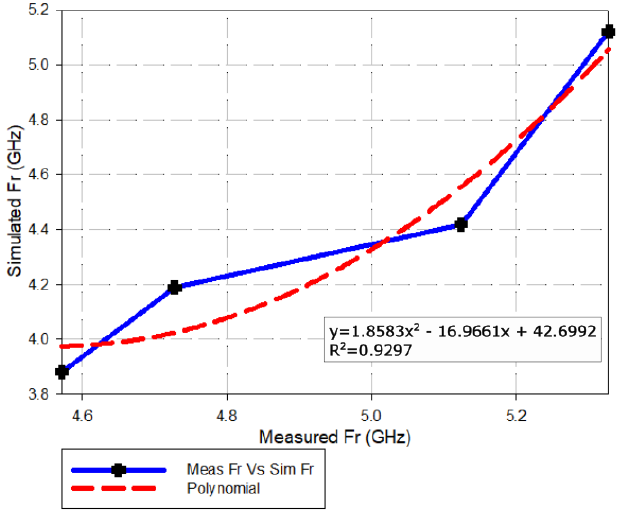
Figure 24. Di ff erence of simulated against measured resonance frequency of the MUT. Figure 24. Difference of simulated against measured resonance frequency of the MUT. Furthermore, the calibrated frequency from the proposed resonator is obtained using Equation (8), as shown in Table 5, where fr cal is the calibrated resonant frequency. fr cal can be used to determine the permittivity value of the MUT. To determine the permittivity of the MUT, the resonant frequency from the simulation results and the reference permittivity were used to obtain a mathematical model of the fitted curve with a second-order polynomial, as shown in Figure